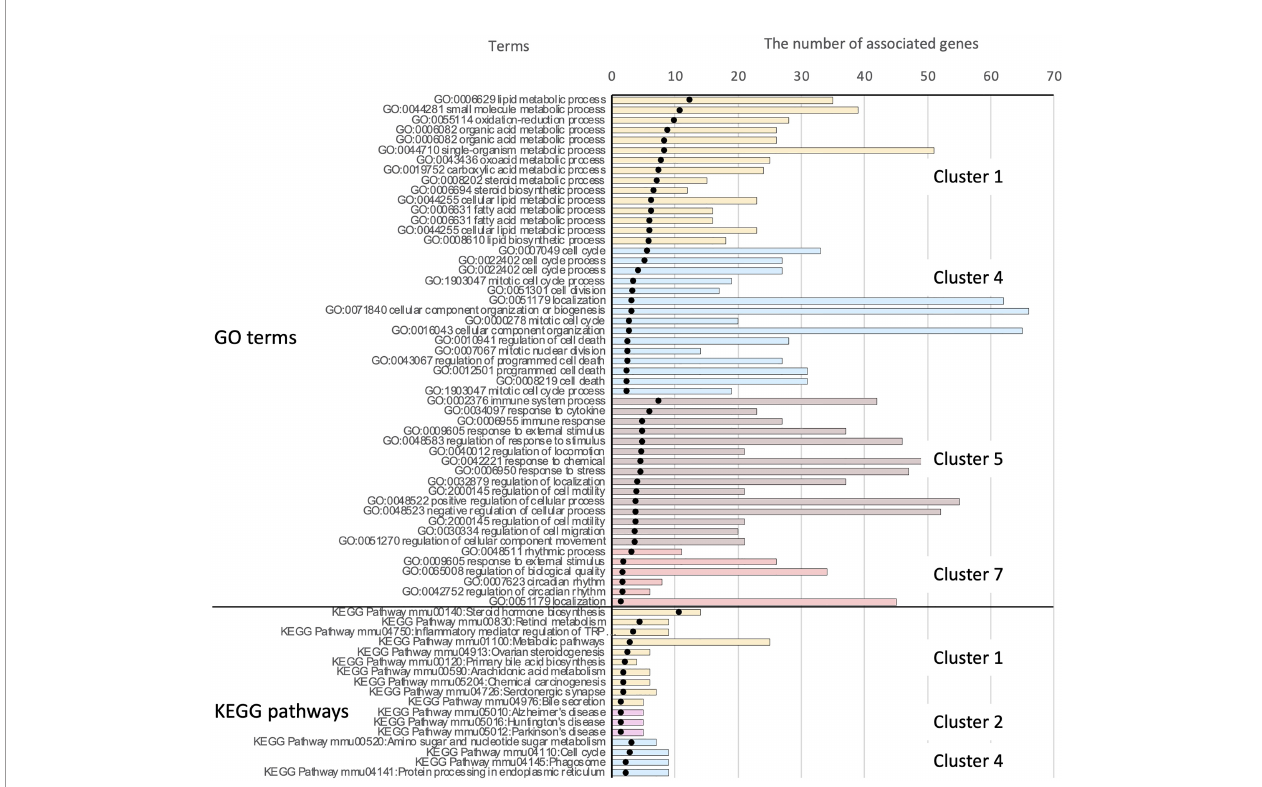
FIGURE 8 | Results of functional enrichment analysis. Owing to the large number of signi fi cant GO terms (corrected p < 0.05), only the top 15 signi fi cant terms from each cluster are shown. For results of KEGG pathway analysis, all signi fi cant pathways are presented. Black dots indicate the – log10 of Benjamini-Hochberg- corrected p-values. The top 51 bars show the results of GO enrichment, and the bottom 17 bars show enriched KEGG pathways. Bars showing the associated clusters are